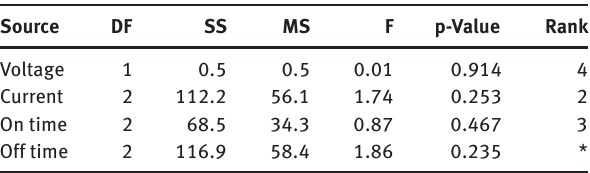
O MMCs. 2 3 O Table 10: Analysis of variance for SR in the machining of 2024 2 3